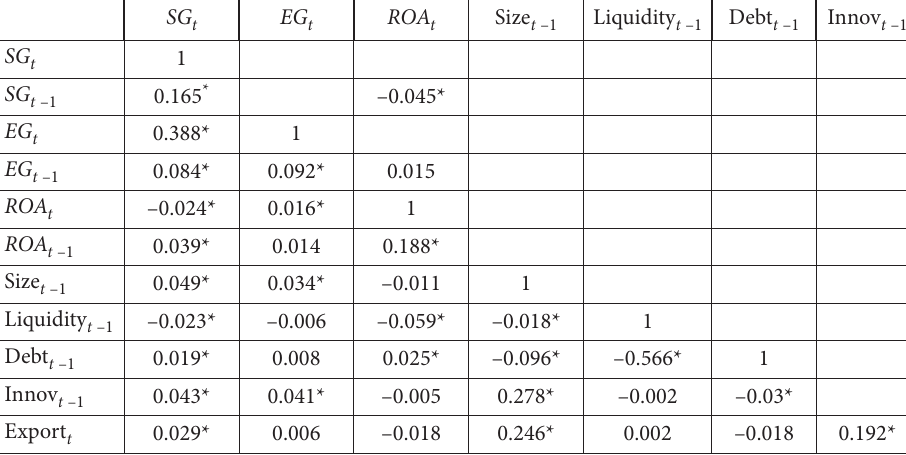
Table 2. Results of the correlation analysis